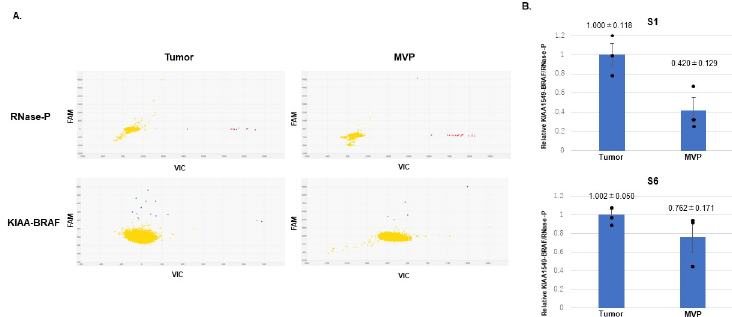
Fig 4. Digital PCR for quantitative fusion gene evaluation. (A) Raw digital PCR data for S1. RNase-P was employed as an internal control. Red dots showed droplets with RNase-P DNA and blue dots with the KIAA-BRAF fusion gene. Yellow dots showed droplets with no DNA. (B) The relative expression of the KIAA-BRAF fusion gene in tumor cells and cellular components of MVP is shown. The ratio of cells harboring the KIAA-BRAF fusion gene (cellular components of MVP vs. tumor cells) was 42% in S1 and 76% in S6. The results are expressed as the mean +- S.E.M., n =